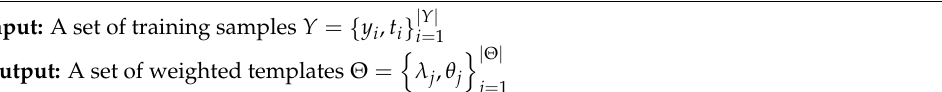
Algorithm 1: Algorithm for Weighted Template